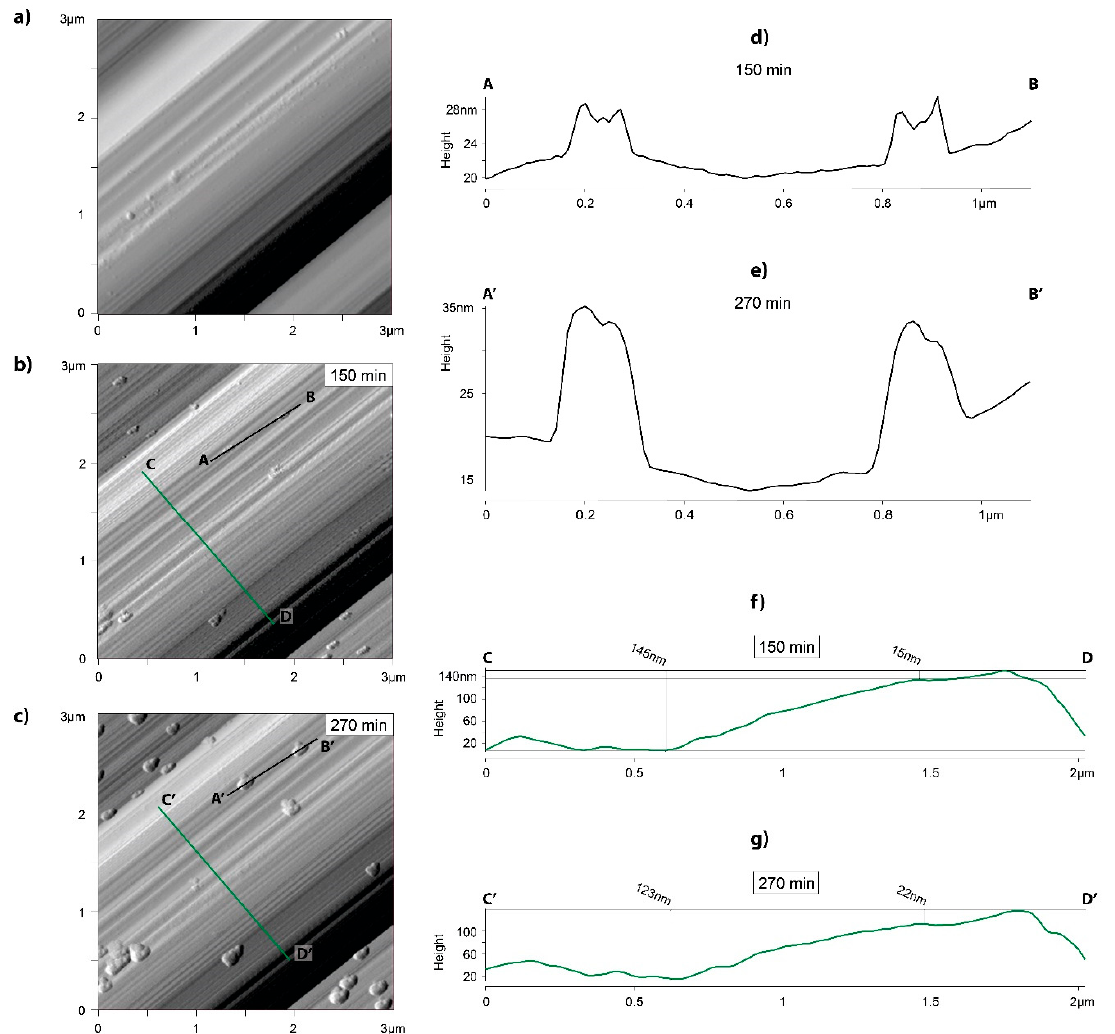
Figure 9. AFM images in amplitude retrace of same area on erionite surface at 25 °C, ( a ) in water and at different interaction times in Gamble’s solution (pH 8.51): ( b ) after 150 min; ( c ) after 270 min. Sections of growing phase ( d and e ) and steps on surface ( f and g ) are shown.